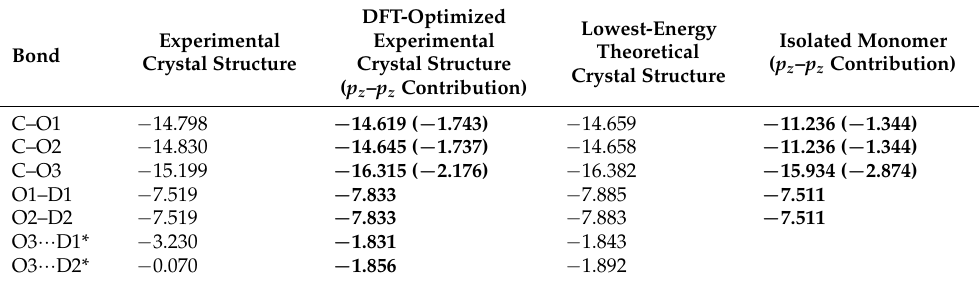
Table A6. Integrated crystal-orbital Hamilton population (ICOHP, in eV) of carbonic acid extracted from plane waves for the experimentally determined crystal structure, the DFT-optimized experi- mental crystal structure (in bold face, see text), the lowest-energy theoretical crystal structure, and the isolated monomer (in bold face, see text).